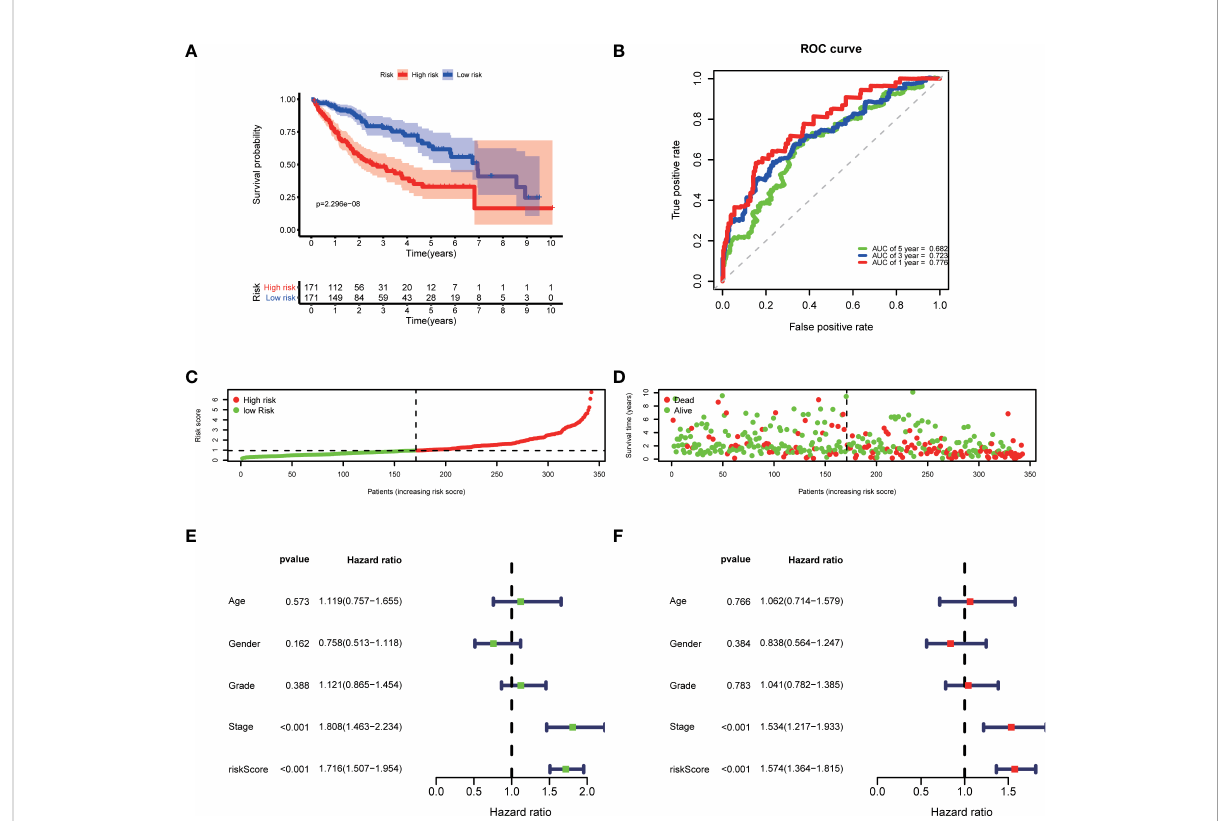
FIGURE 3 Development of the prognostic model based on COVID-19/HCC associated genes in the TCGA cohort. (A) Kaplan-Meier survival analysis between the high- and low-risk patients. (B) Time-dependent ROC curves at 1,3,5-years. (C) Distribution of risk scores, (D) survival status of each patient. (E) Univariate and (F) multivariate Cox regression